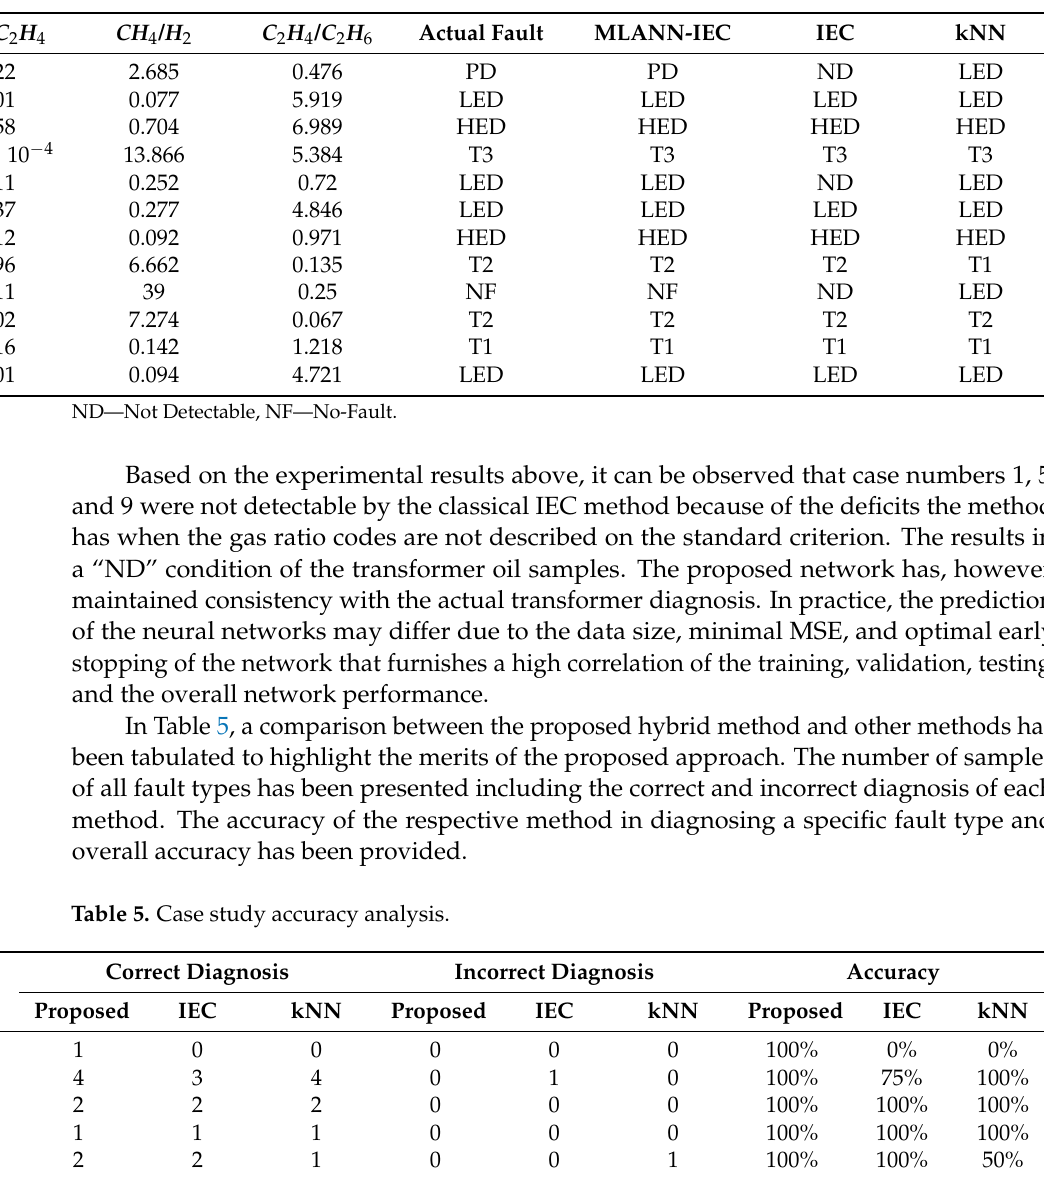
Table 4. Transformer case studies.